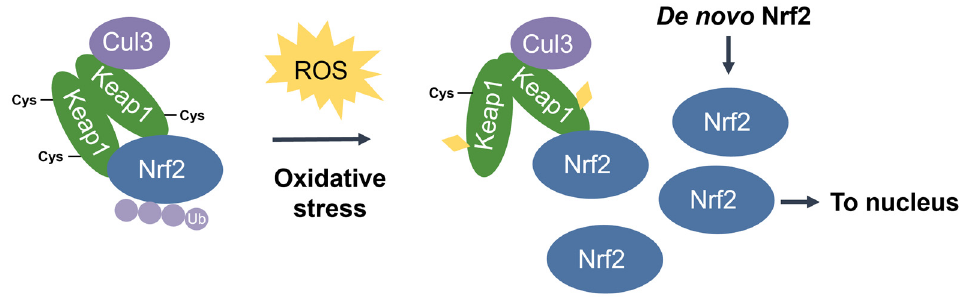
Figure 6. Stress-induced cysteine modification of Keap1. Under oxidative stress conditions, specific stress-sensing cysteine residues in Keap1 are modified, leading to a conformational change in Keap1 that results in Nrf2 stabilization, accumulation, and nuclear translocation for the induction of ARE- containing cytoprotective genes.